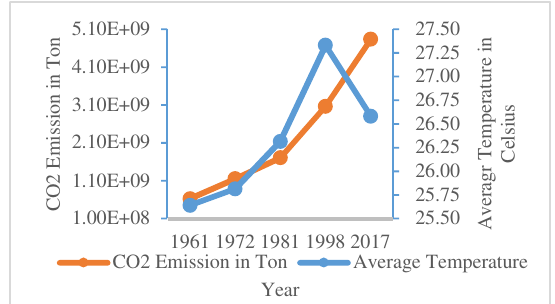
Fig. 13: Average Temperature and Co 2